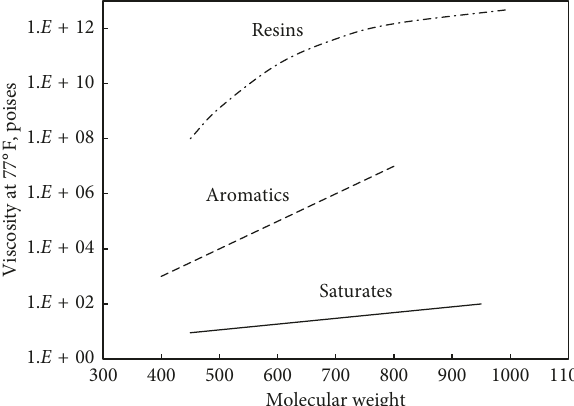
Figure 3: Changes in viscosity for different asphalt fractions under differentmolecularweights.TheleftfigureisobtainedfromGriffinetal. (under the creative commons attribution license/public domain) [15].